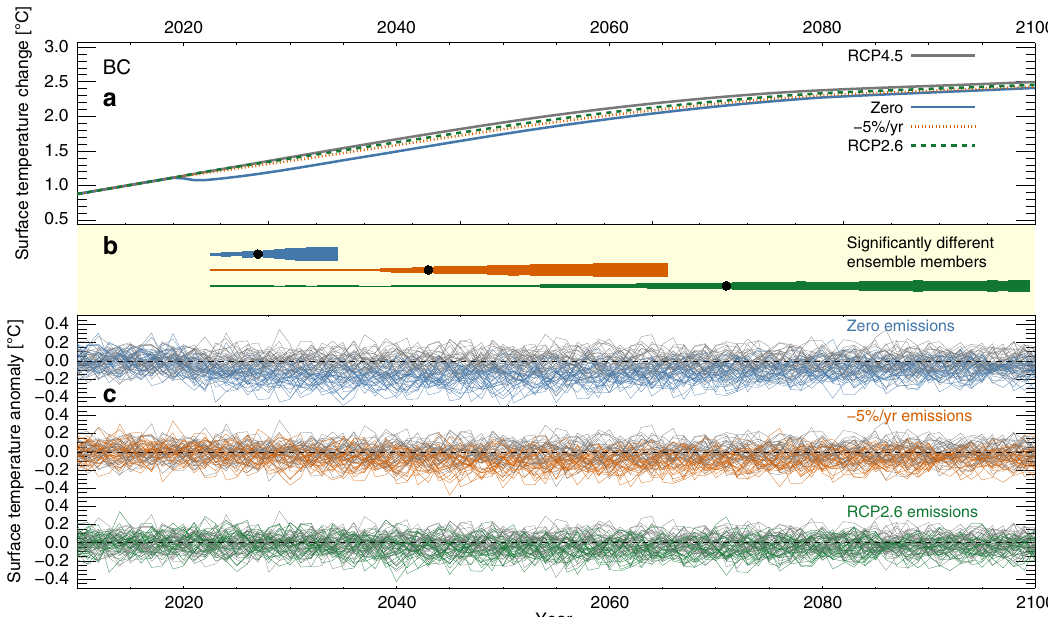
Fig. 2 Single component mitigation. Example of the emergence of a temperature signal when mitigating one climate forcer. a MAGICC6 calculations following RCP4.5 (black line), and then modi fi ed by mitigating BC emissions according to one of three idealized scenarios starting in 2020 (zero emissions, − 5% per year, or switching to RCP2.6). b The number of ensemble members where the temperature time series, from 2020 and up to that year, is signi fi cantly different from zero ( t -test, p < 0.05). Black dot: 21 signi fi cant ensemble members (66%). c The (detrended) temperature difference when variability from CESM1 LENS is taken into